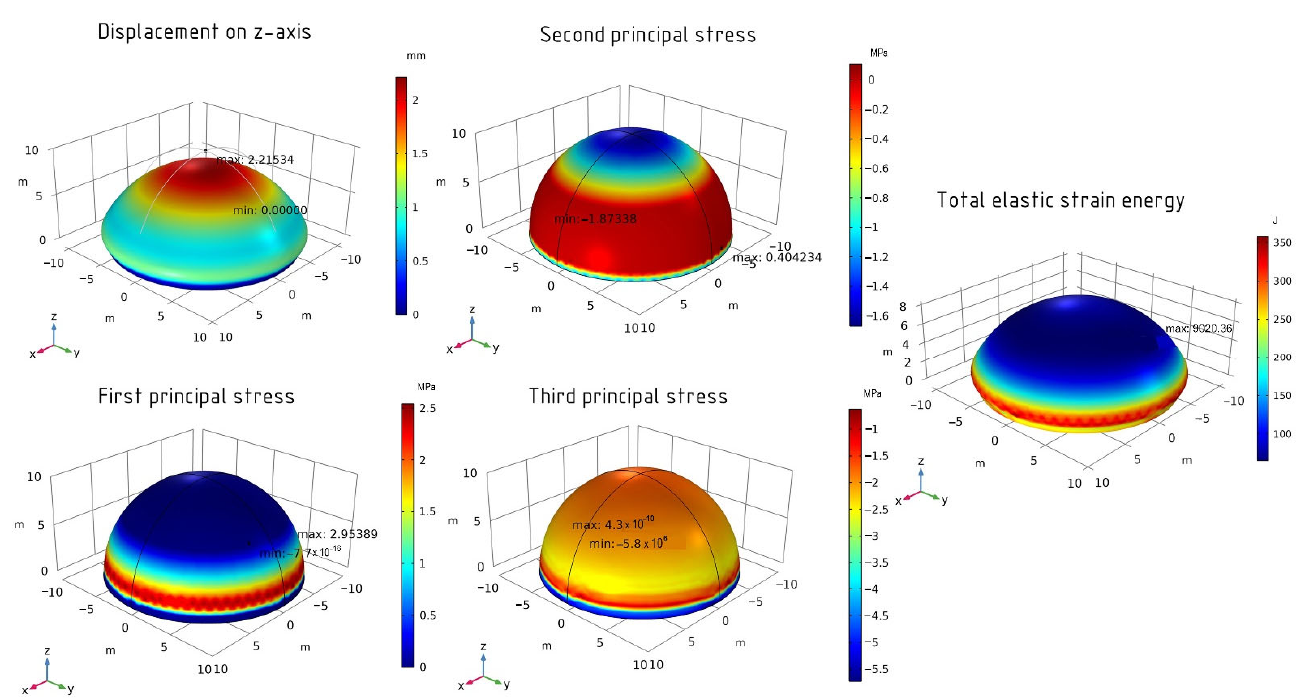
Figure 6. The structural analysis of the sphere shell (fine element size).